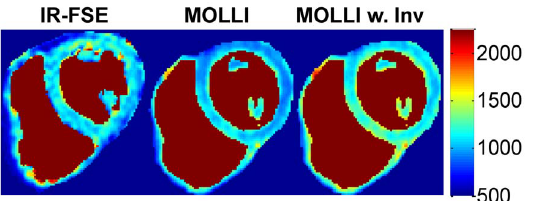
Figure 4. Example of myocardial T 1 maps (in ms) obtained with IR-FSE, conventional MOLLI fitting and MOLLI fitting with inversion correction at a 30 6 flip angle. The IR-FSE image was taken in a separate breath-hold than the MOLLI and therefore it is at a slightly different position. Blood has been segmented out to minimize distraction due to the blood T 1 : IR-FSE spoils the blood signal and is not able to fit for blood T 1 , however MOLLI is able to fit for T 1 in the blood.